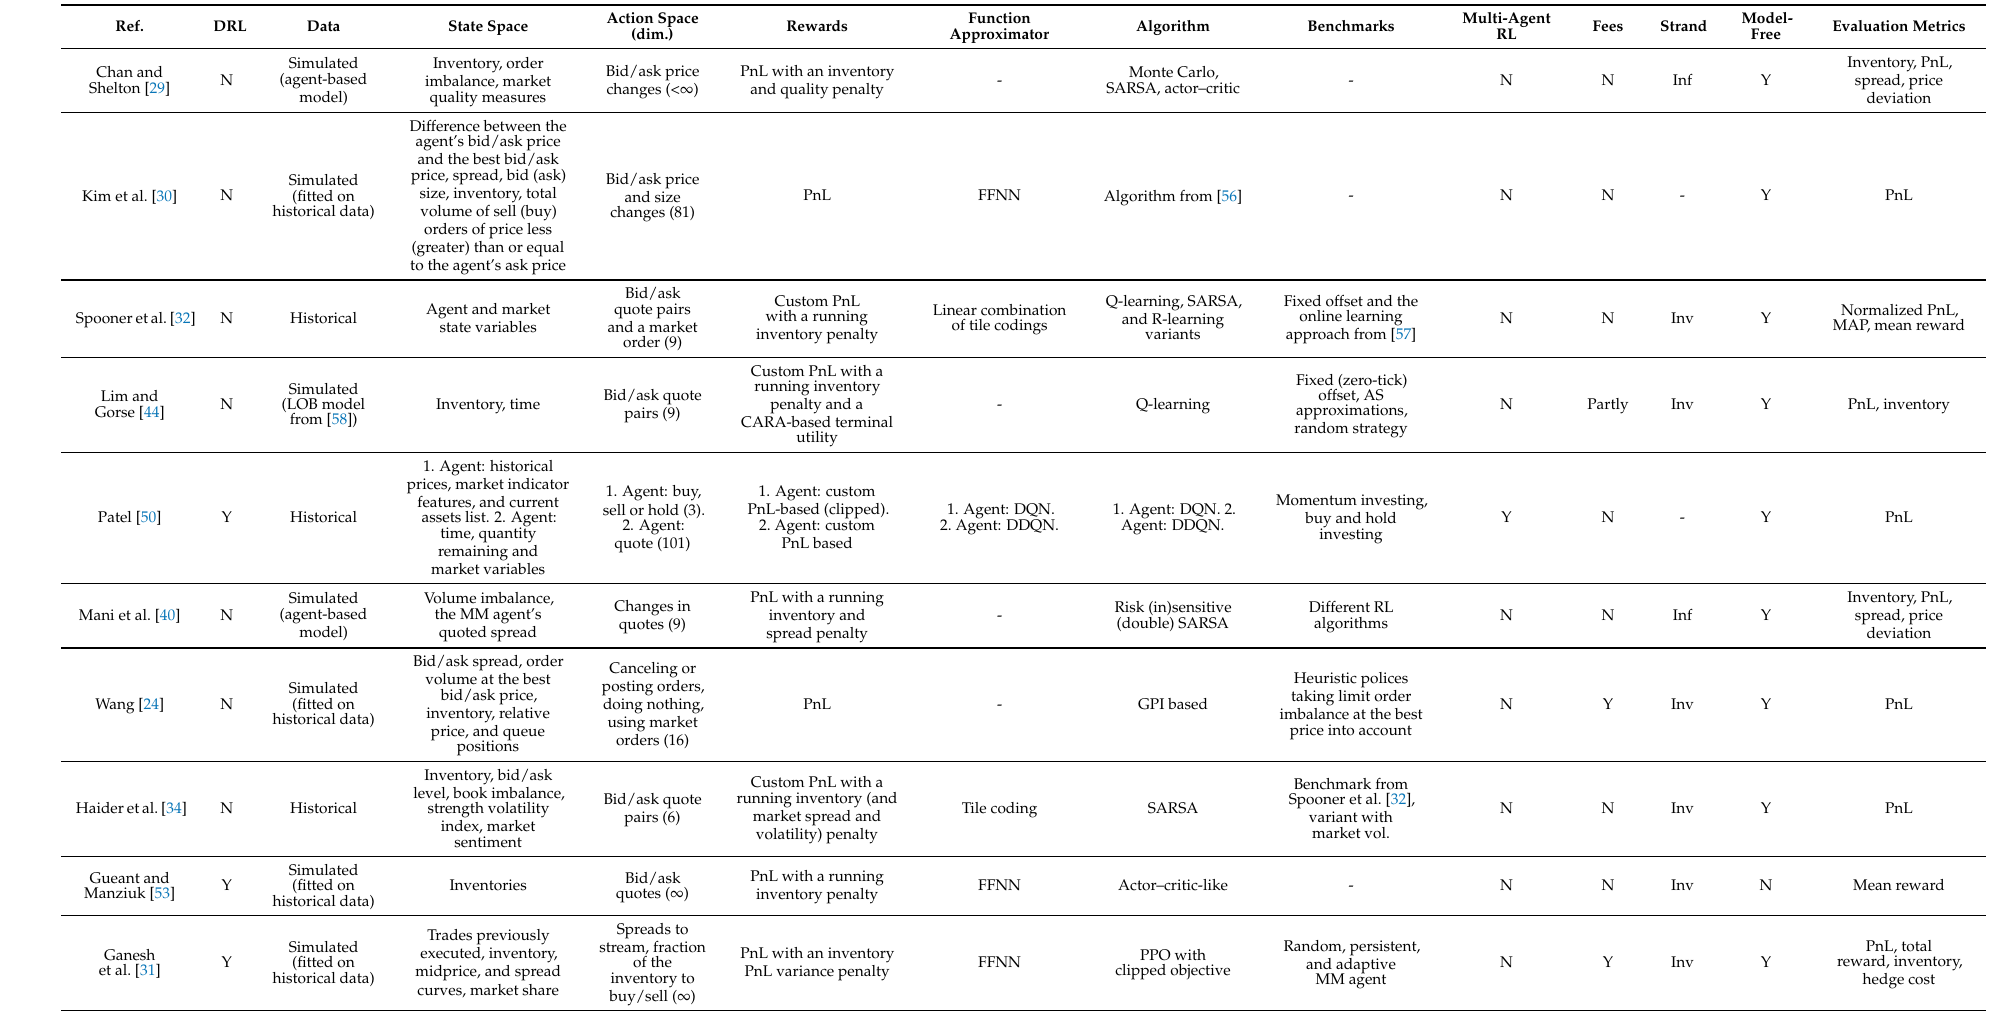
Table 1. Overview of the characteristics of different (D)RL approaches in the